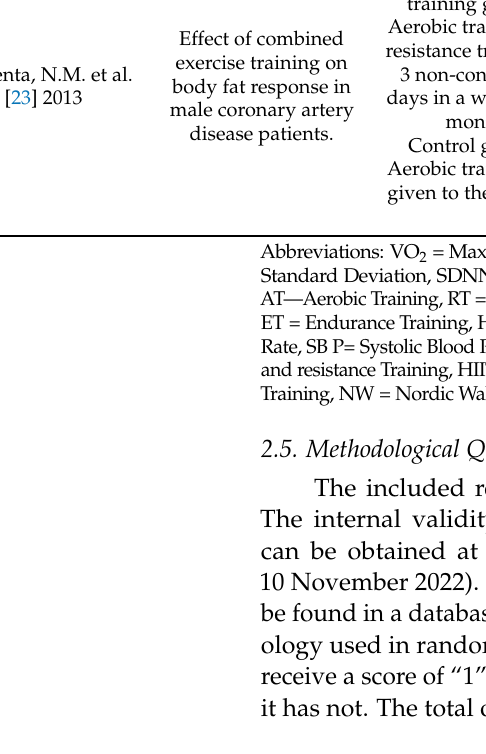
Table 3. Methodological quality assessment via PEDro